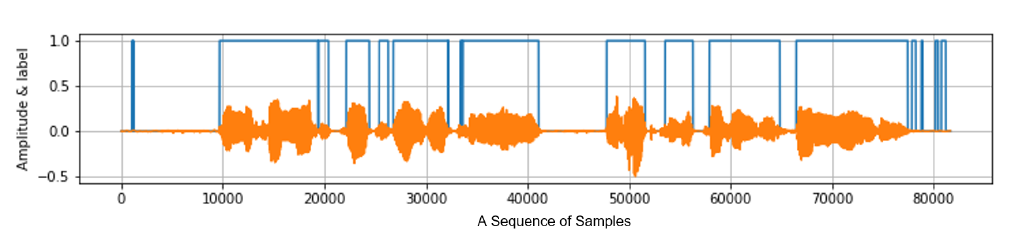
Figure 18. The result of entropy-based filtering with fuzzy clustering.